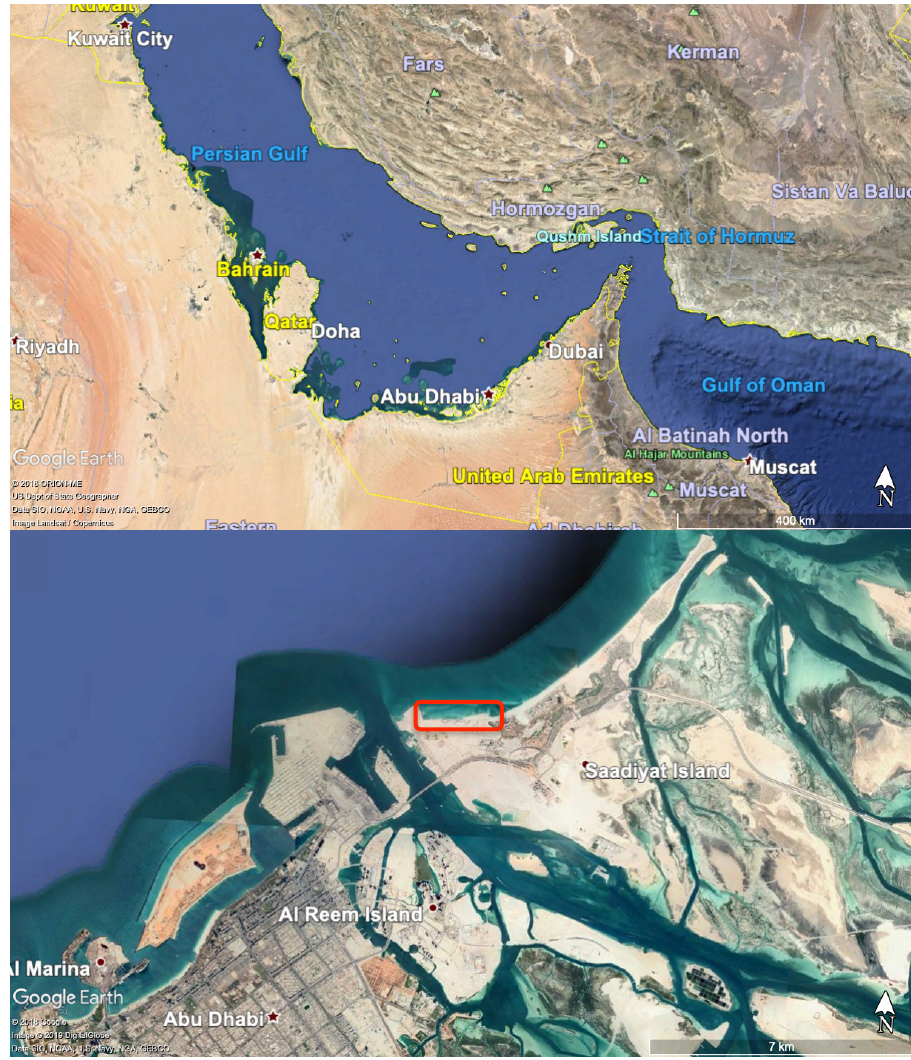
Figure 1. Top: view of the Arabic Gulf area showing the position of Abu Dhabi; bottom: aerial view of Saadiyat island, in the Abu Dhabi Municipality; the red rectangle indicates the position of the Saadiyat beach study